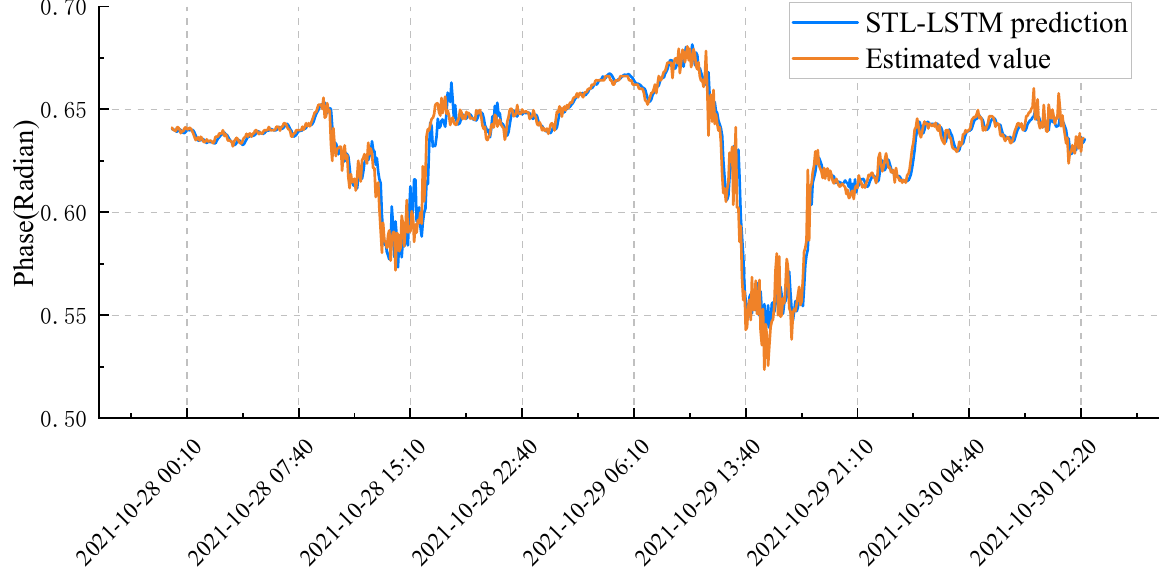
Figure 9. Time series change diagram of atmosphere phase prediction.